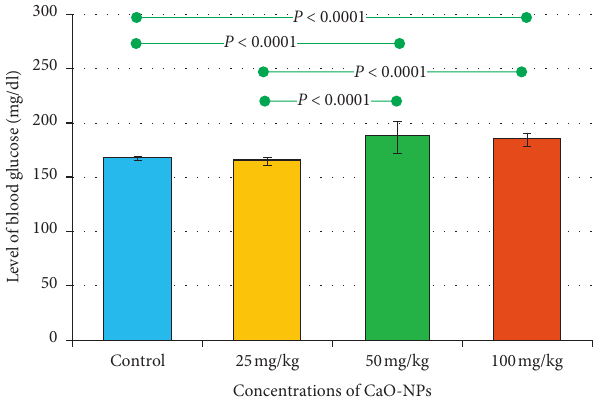
Figure 7: Bar chart showing mean values of the blood glucose level in the teeth of Wistar rats after 60 days of CaO-NP administration at different dosages (25, 50, and 100mg/kg) and the nontreated control group. Horizontal lines connecting two bars indicate statistical significance ( P < 0 . 05). Table 4: Mean values of the blood glucose level in Wistar rats after 60 days of CaO-NP administration at different dosages (25, 50, and 100mg/kg) and the nontreated control group.